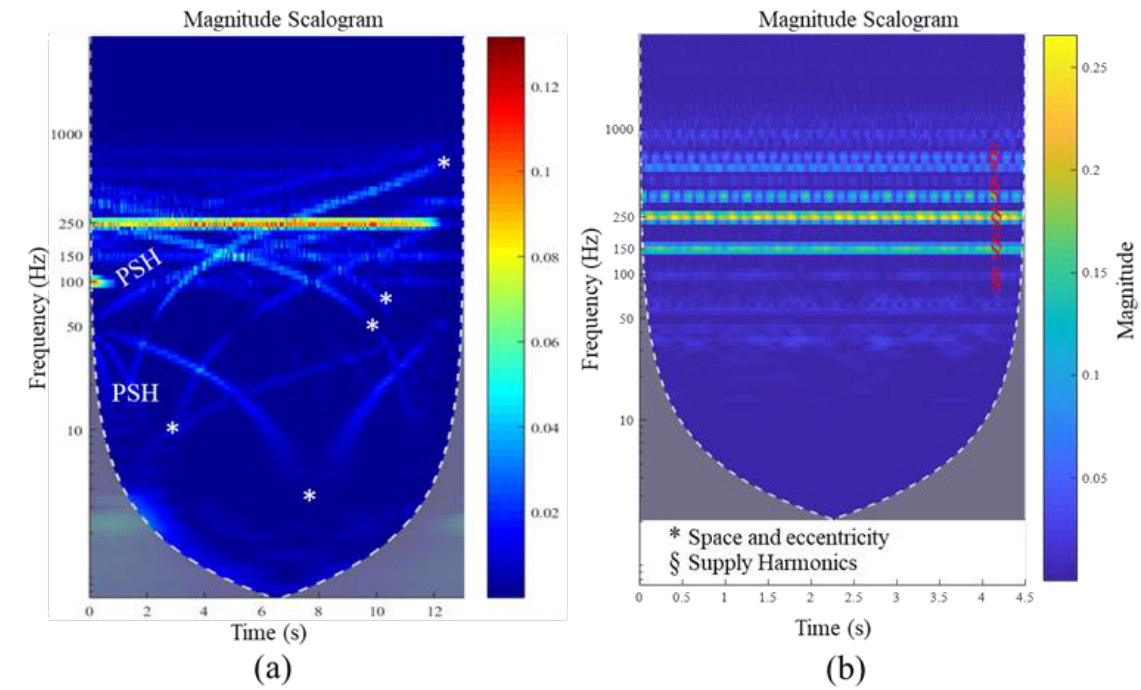
Figure 10. The generation of spatial harmonics in the stator current of the healthy machine. ( a ) The development of time–frequency patterns due to the space harmonics. ( b ) The time-frequency spectrum under a steady state regime under 50% of the rated load.